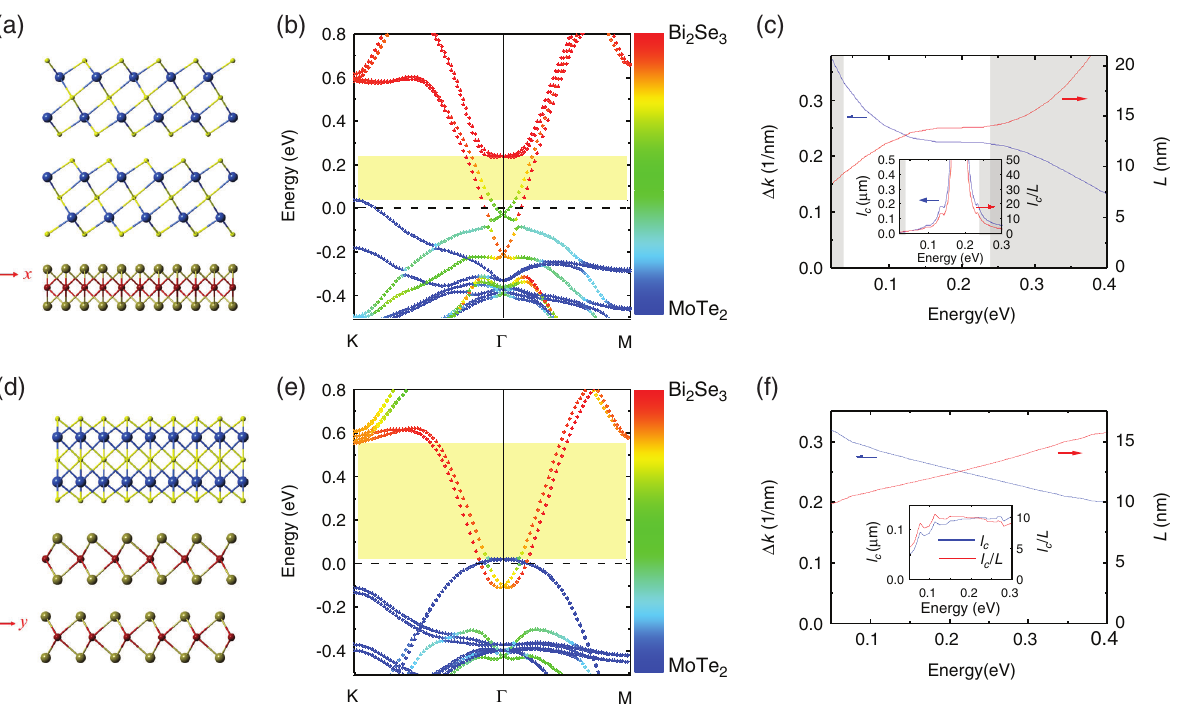
Fig. 5 a Side view of the 2QL-Bi 2 Se 3 /1TL-MoTe 2 heterostructure. b Band structures of the 2QL-Bi 2 Se 3 /1TL-MoTe 2 . The Bi 2 Se 3 and the MoTe 2 components are represented by the color of the dots . The yellow-shaded region indicates the energy region for ideal RB states. c The WND between the two RBs Δ k of the 2QL-Bi 2 Se 3 /1TL-MoTe 2 heterostructure and the corresponding spin precession length L as functions of energy. The inset shows the coherence length l c and the ratio of the l c to the spin precession length as functions of energy. The shaded regions indicate the energy regions where the other states (high-energy quantum well states or the MoTe 2 states near the K point) are involved. d – f are the counterparts of a – c , respectively, for the case of the 1QL-Bi 2 Se 3 /2TL-MoTe 2